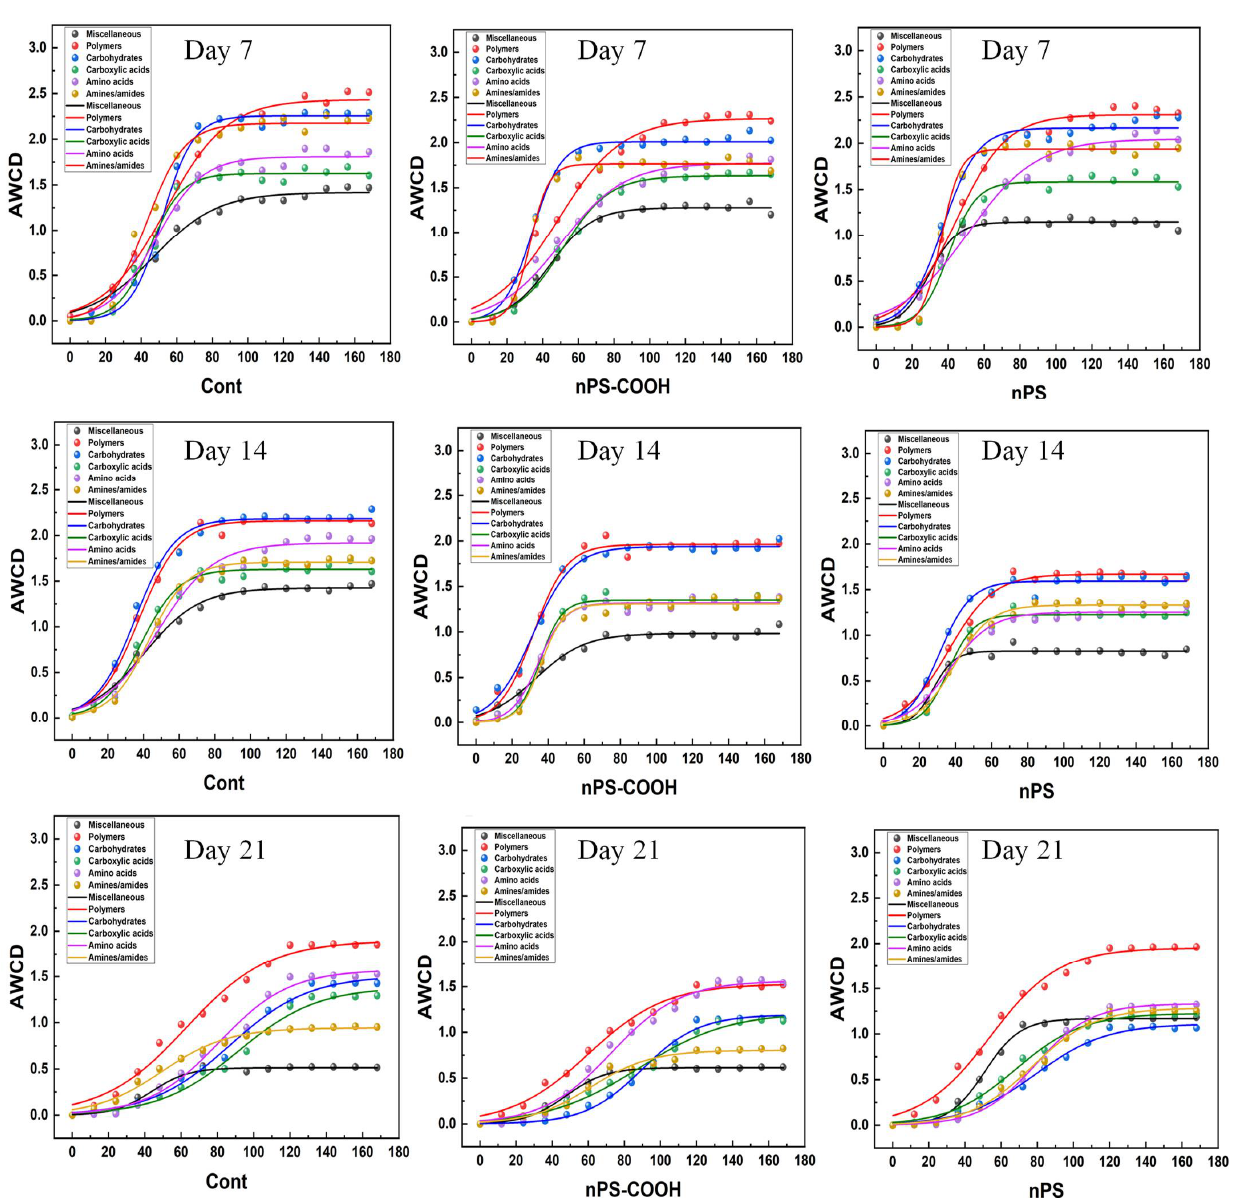
Figure 4. Comparison of metabolic capacity of the six biochemical categories of carbon of biofilms exposed to PS NPs with different surface modifications at day 7, day 14, and day 21 ( n = 3). The variation in AWCD of six types of carbon sources at different time points was